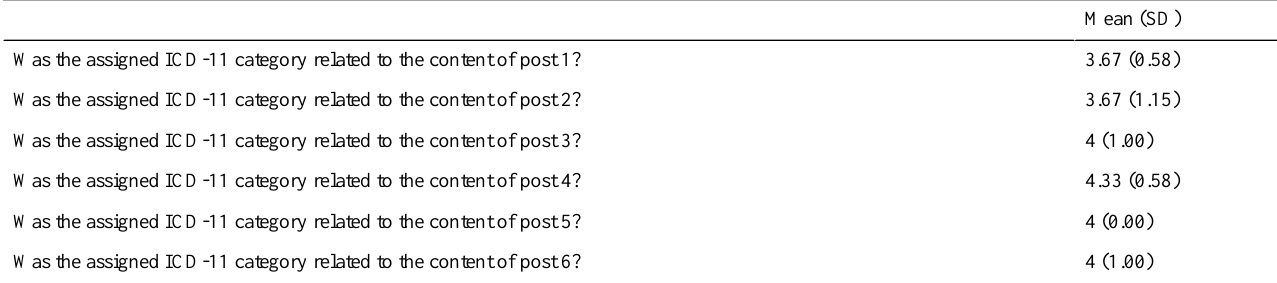
Table 11. Relatedness of the ICD-11 categories to the aggregated gastroenterology posts.